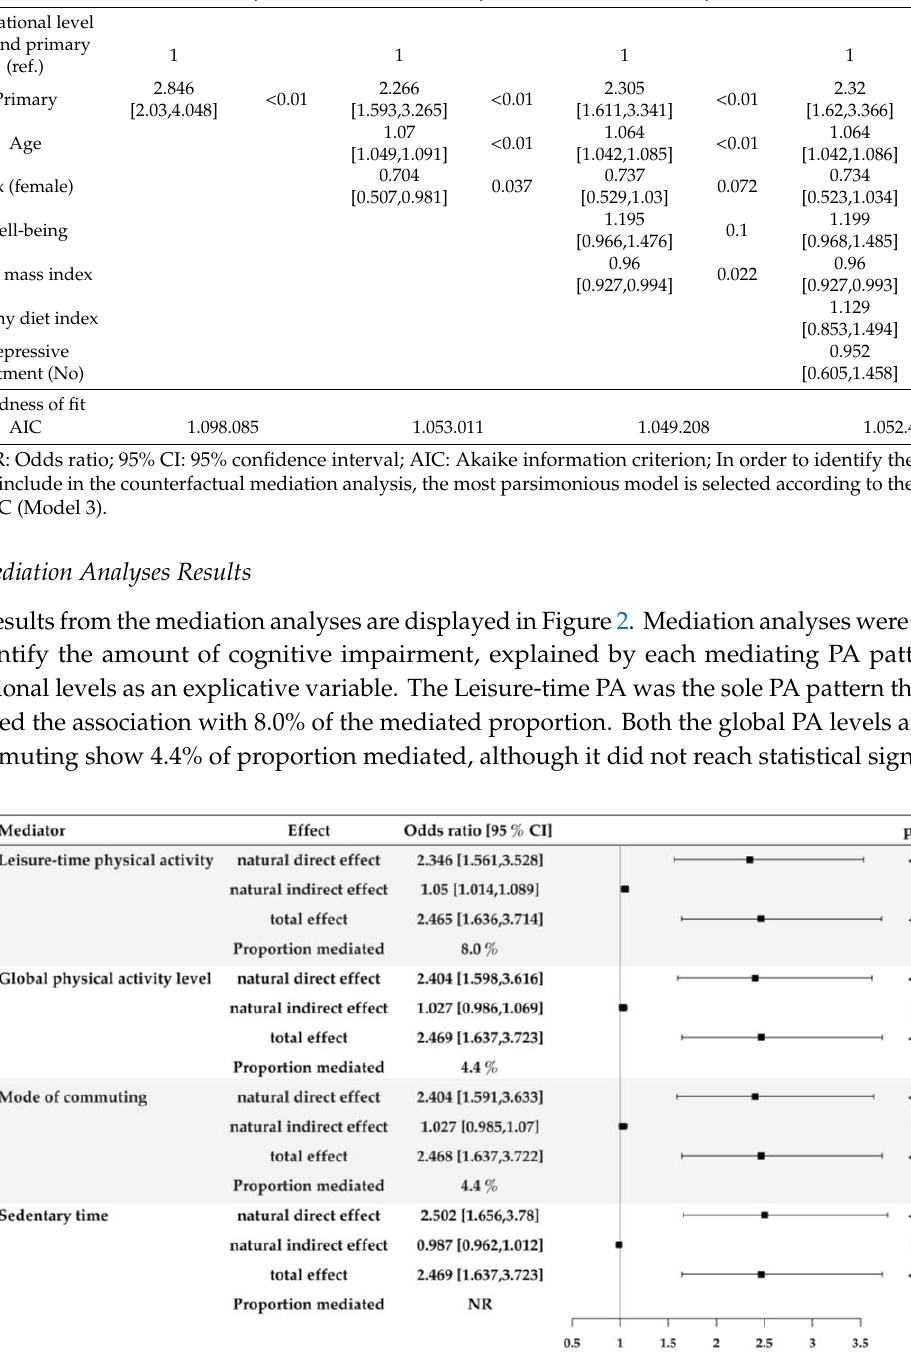
Figure 2. Counterfactual mediation analysis on primary vs beyond primary (reference) educational level. NR is expressed when the natural direct and natural indirect relationships were not in the same direction; therefore, the mediated proportion is not a logical value.